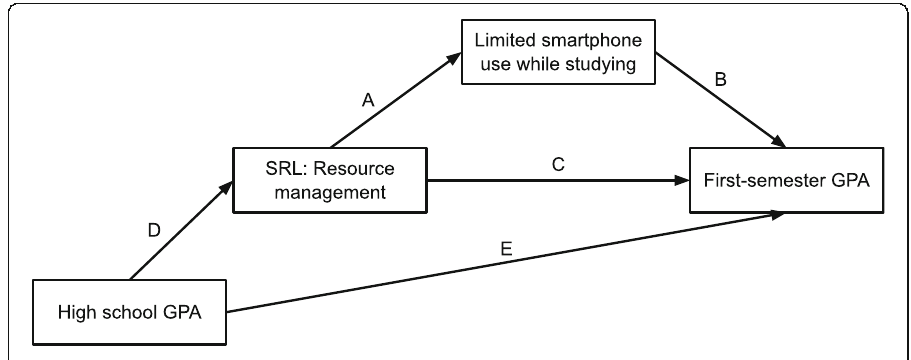
Fig. 1 Proposed Model of Resource Management, Limited Smartphone Usage and 1st Semester